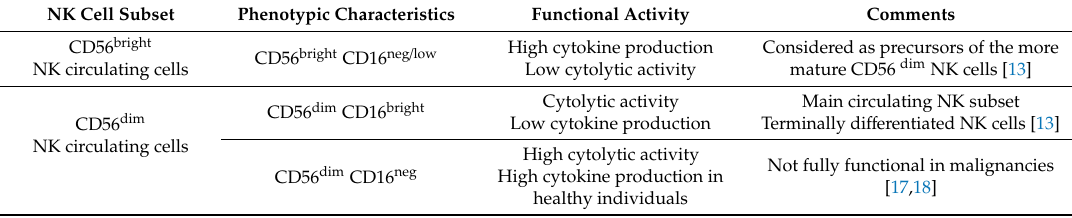
Table 1. Summary of described NK cell subsets. The upper four rows report NK cell subsets are identified among circulating NK cells. Rows filled in grey depict NK subsets recognized within the